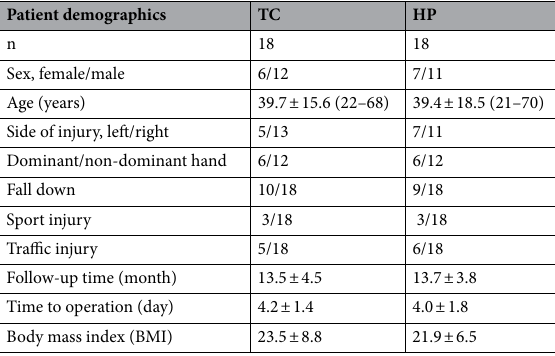
Table 1. Comparison of preoperative general data.